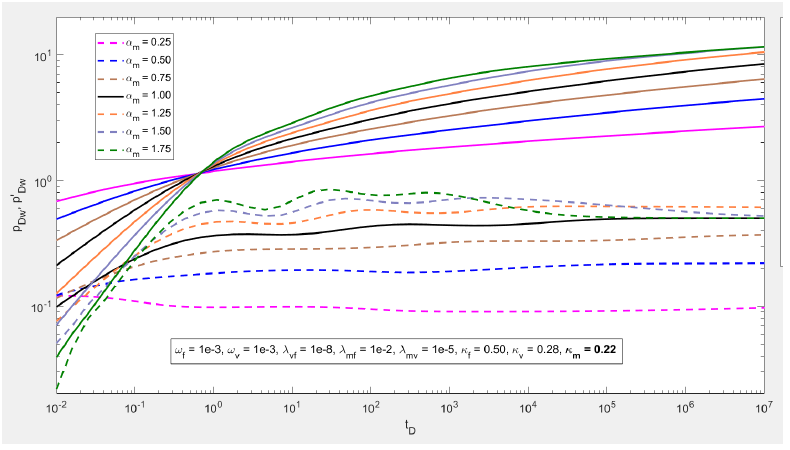
Figure 5. Effects of considering anomalous flow only in matrix rock, α f = 1, α v =